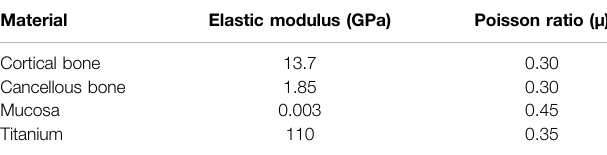
TABLE 1 | Elastic modulus and Poisson ratio of different